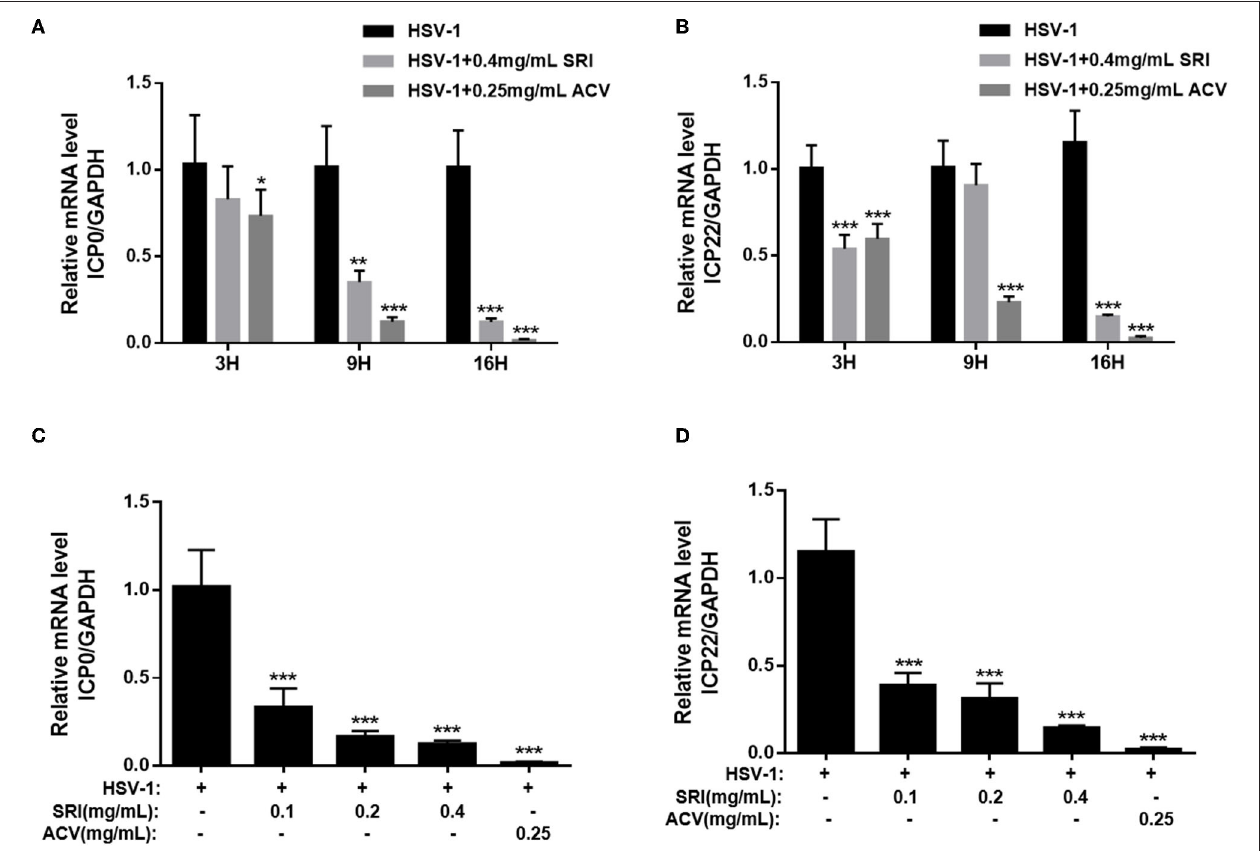
FIGURE 3 | SRI repressed HSV-1 IE gene expression. (A–D) Confluent cells were infected with HSV-1 for 2h and then treated with the designated concentrations of SRI (0.05, 0.1, 0.2, and 0.4 mg/mL) or ACV (0.25 mg/mL). Total RNA was extracted at the indicated time points (3, 9, and 16h) and RT-PCR was employed to analyze the ICP0 and ICP22 mRNA levels (A,B) . The effects of SRI and ACV on ICP0 and ICP22 genes of the virus were determined after 16h (C,D) . The level of gene transcription was normalized by GAPDH. The data are presented as mean ± SD. * p < 0.05, ** p < 0.01, and *** p < 0.001, vs. HSV-1